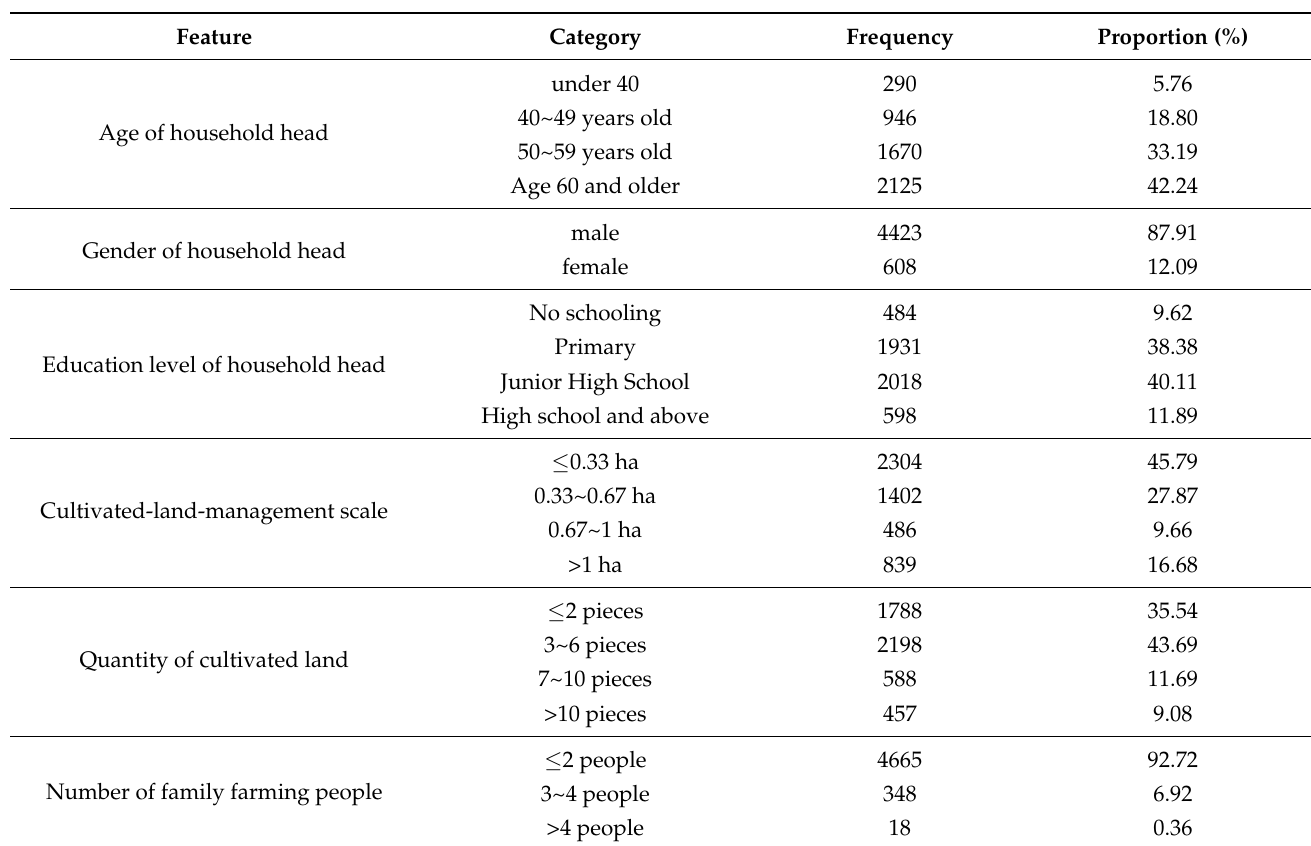
Table A1. Basic characteristics of sample farmers.